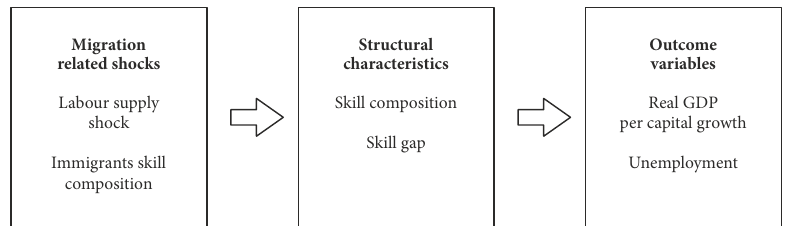
Figure 1. Analyzed transmission